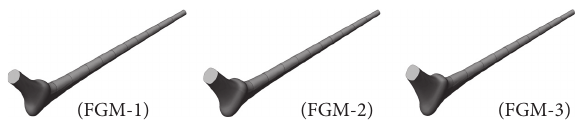
Figure 15: Optimal designs for the functionally graded implant.